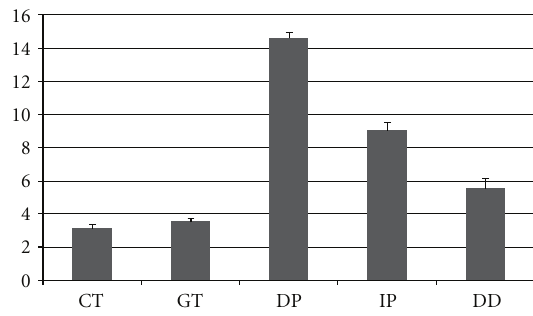
Figure 1: Means and standard errors of scores for the group of healthy participants classified as